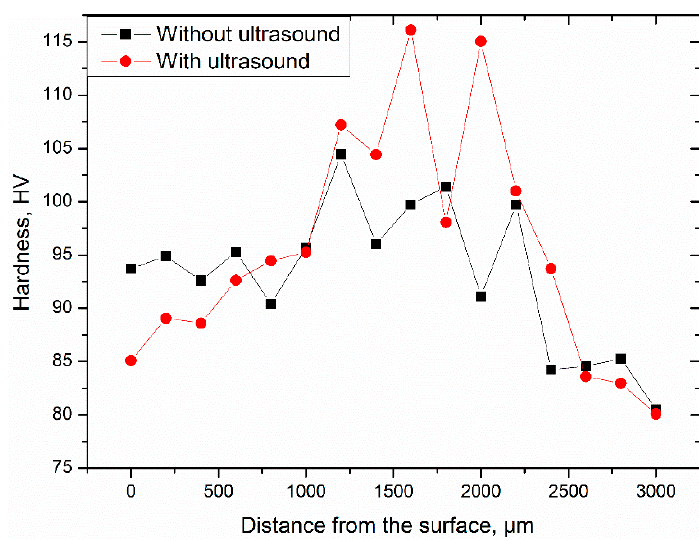
Figure 9. True stresses as a function of strains in the process of upsetting without USV and with the application of USV.